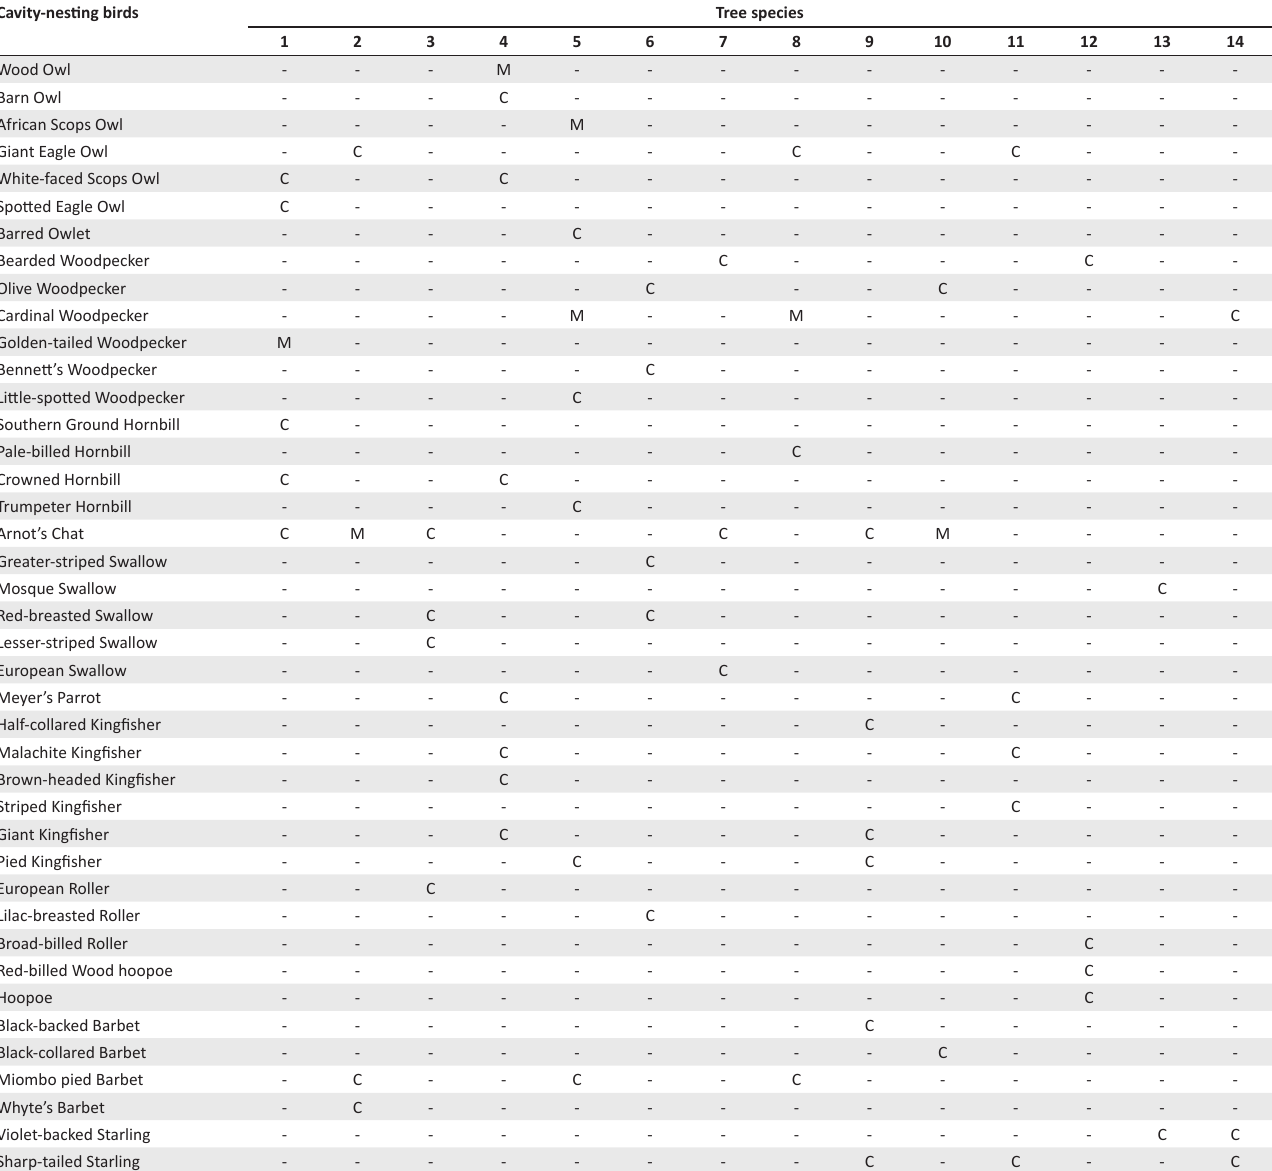
TABLE 4: Cavity-nesting birds and their preferred host tree species in Mwekera National Forests No. 6 and the Chimfushi Wildlife Orphanage forests, Copperbelt Province, Zambia, 2014. Cavity-nesting